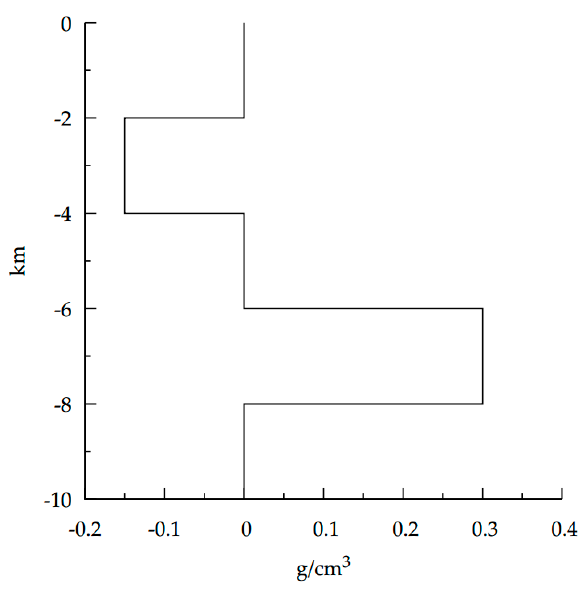
Figure 4. Initial change in model density with depth.